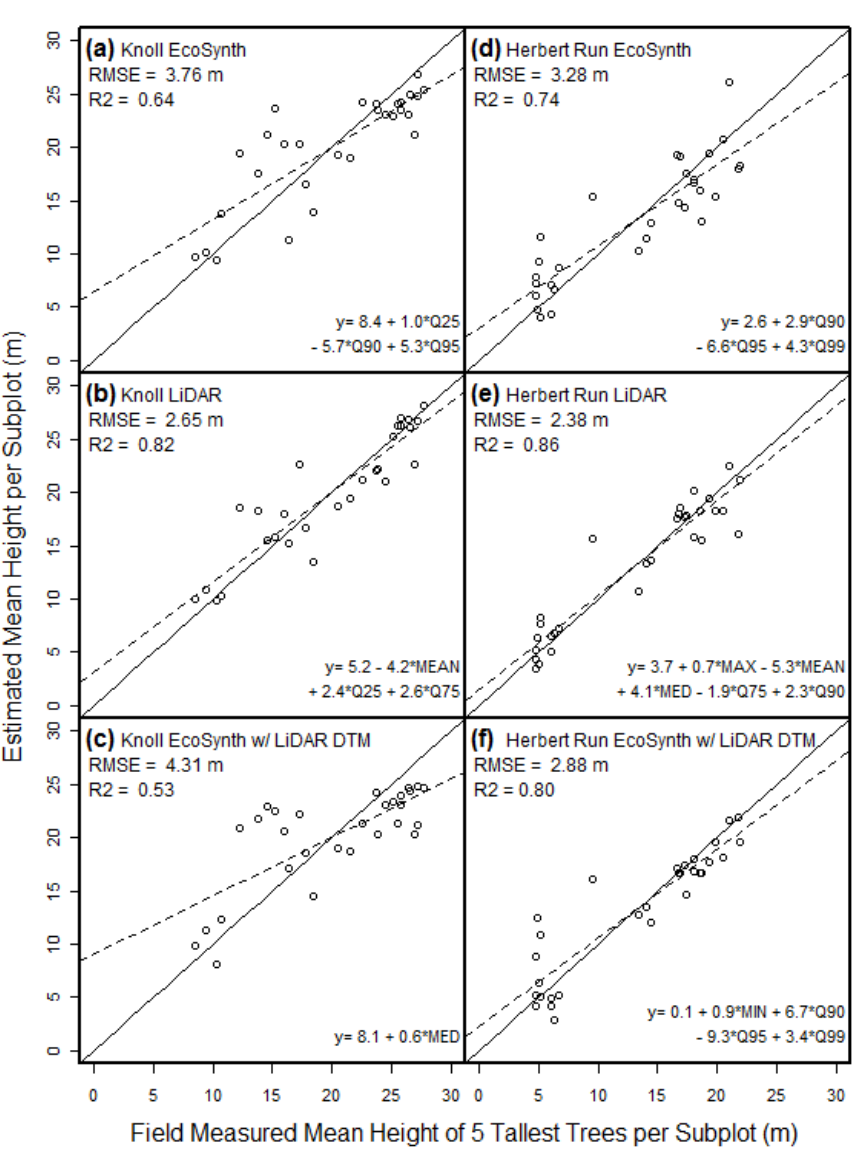
Figure 6. Results of stepwise multiple linear regressions of subplot canopy height metrics from Ecosynth and LiDAR CHMs on field measured canopy heights. Knoll standard Ecosynth ( a ), LiDAR ( b ), and precision Ecosynth with LiDAR DTM ( c ) . Herbert Run standard Ecosynth ( d ), LiDAR ( e ), and precision Ecosynth with LiDAR DTM ( f ). Dashed lines are regression models; solid line is observed = expected. Model parameters are described in Table